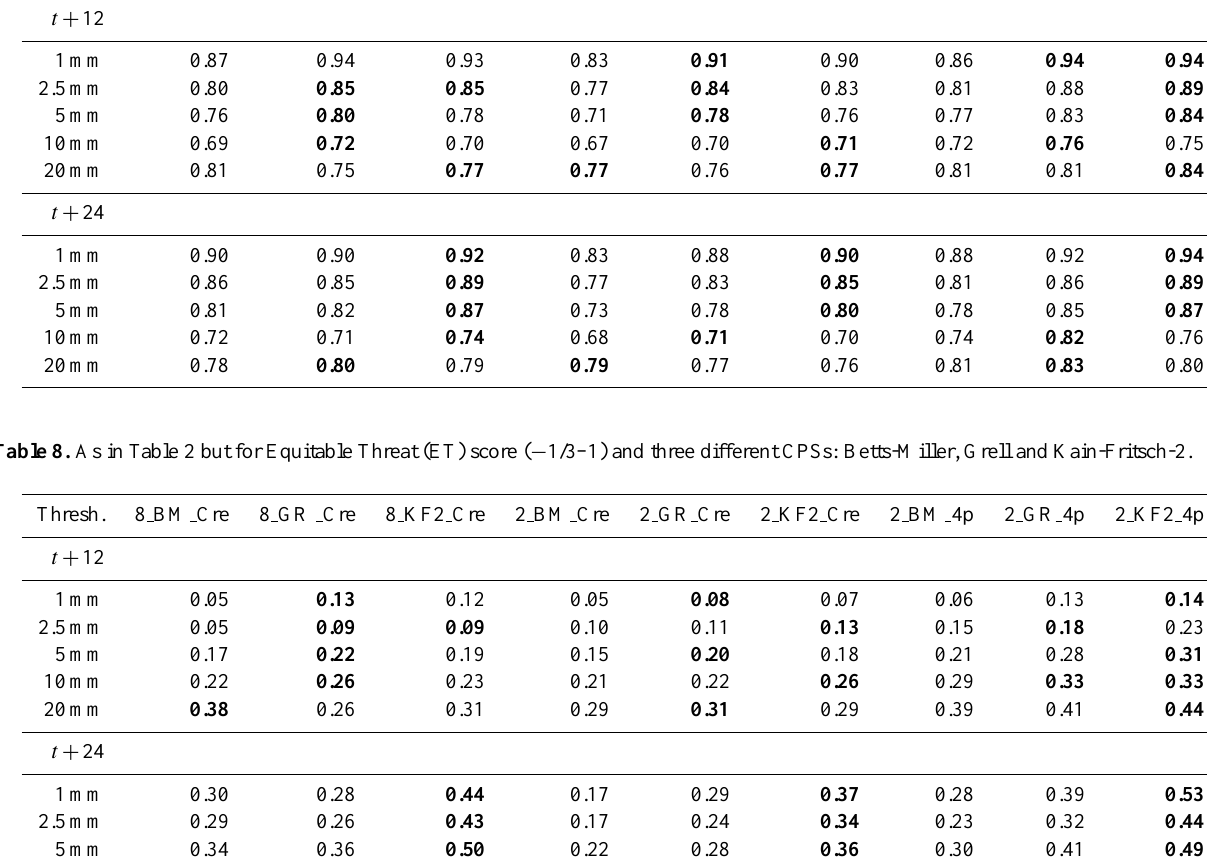
Table 7. As in Table 2 but for Proportion Correct (PC) score (0–1) and three different CPSs: Betts-Miller, Grell and Kain-Fritsch-2. Thresh.